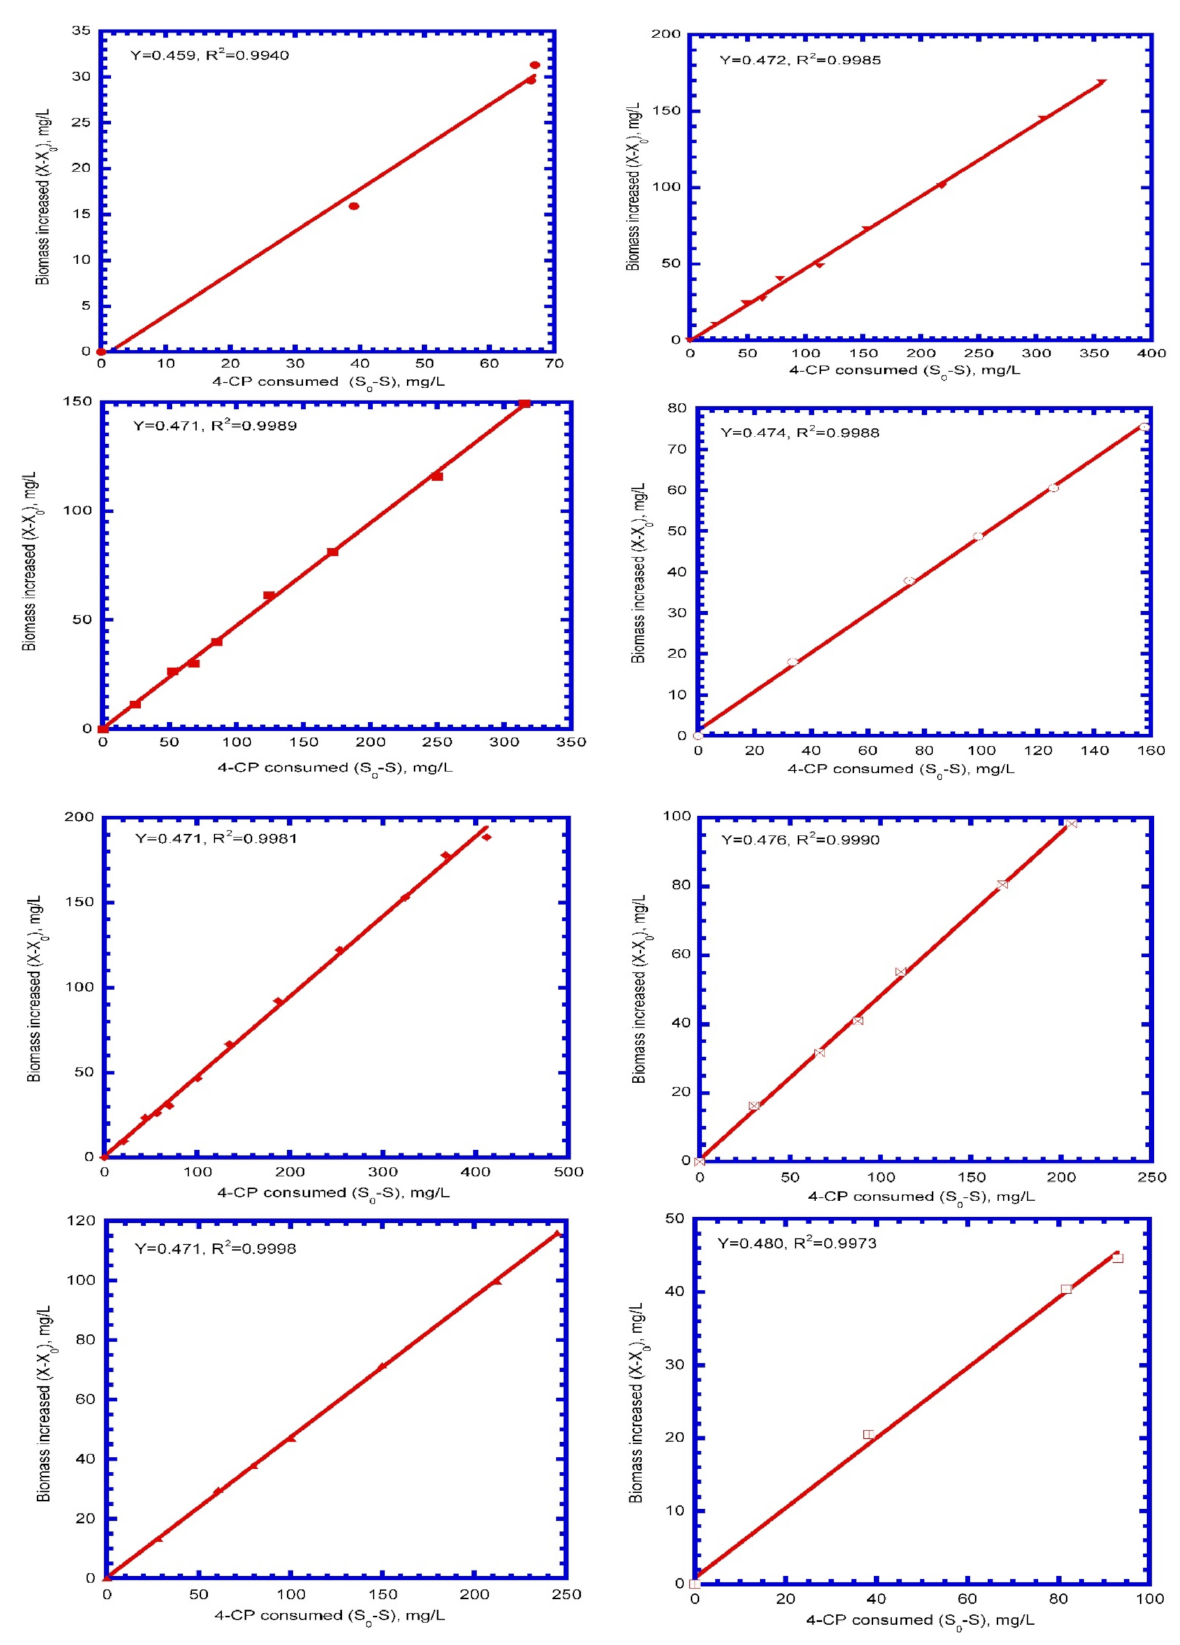
Figure 4. Batch experiments to determine the growth yield ( Y ) at various 4-CP initial